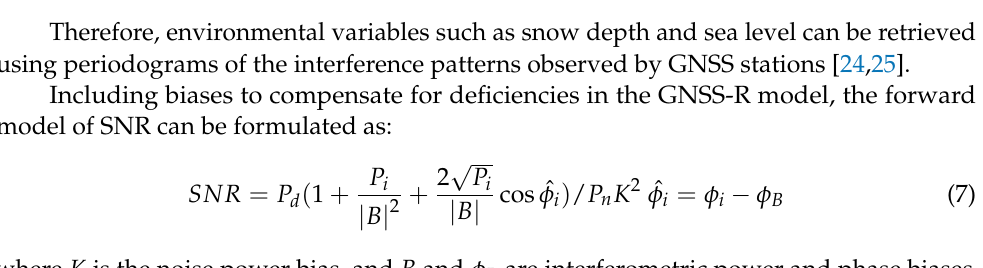
where K is the noise power bias, and B and φ B are interferometric power and phase biases,